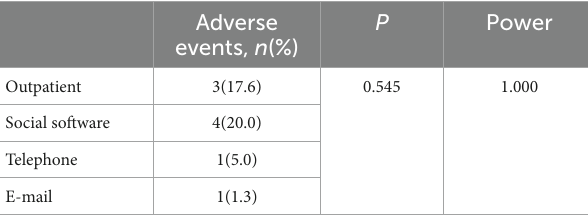
TABLE 3 Adverse events in each group during the 6